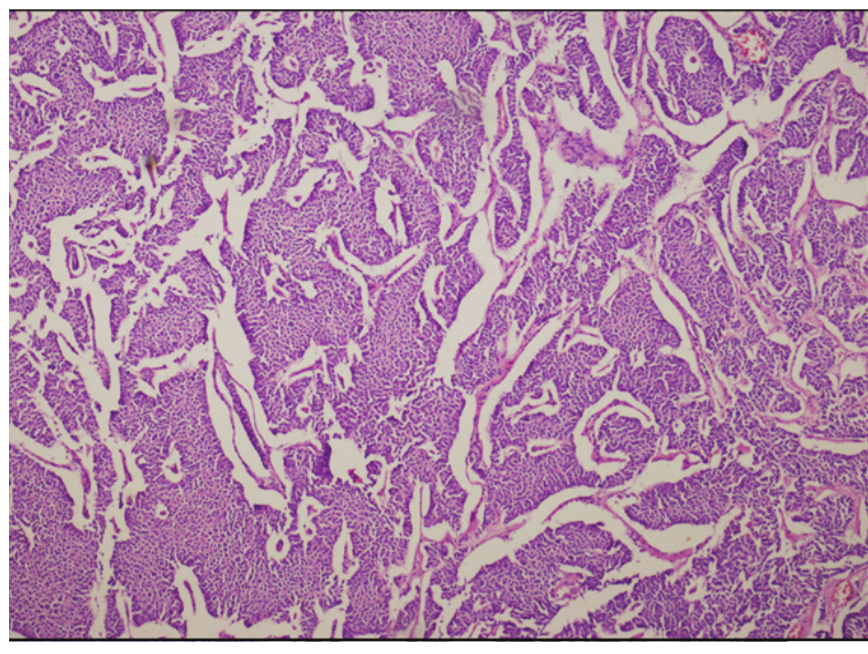
Figure 6 : Well-differentiated pancreatic neuroendocrine tumor (G1), H&E stain × 40.